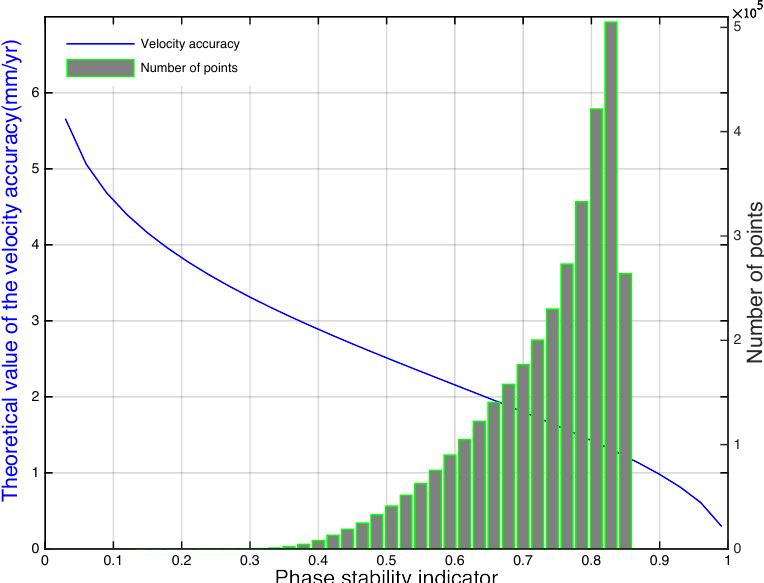
Figure 5. The blue line shows the relationship between the temporal coherence ˆ γ and the theoretical value of the velocity accuracy σ v for PS points (i.e., left-hand vertical axis). The histogram represents the statistic for the calculated coherence of PS points (i.e., right-hand vertical